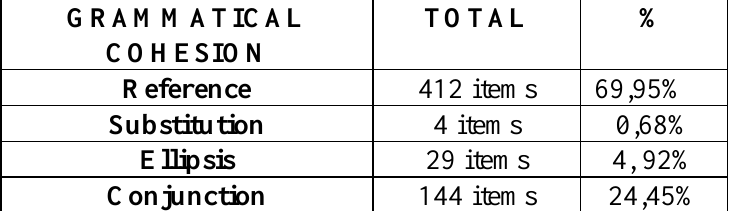
Table 1. Grammatical Cohesion in the Short